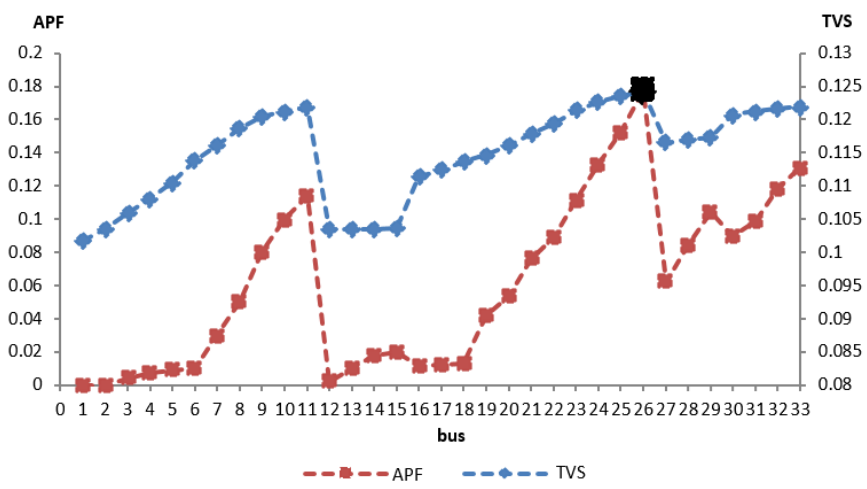
Figure 3. The APF and TVS for determining the first DER location.